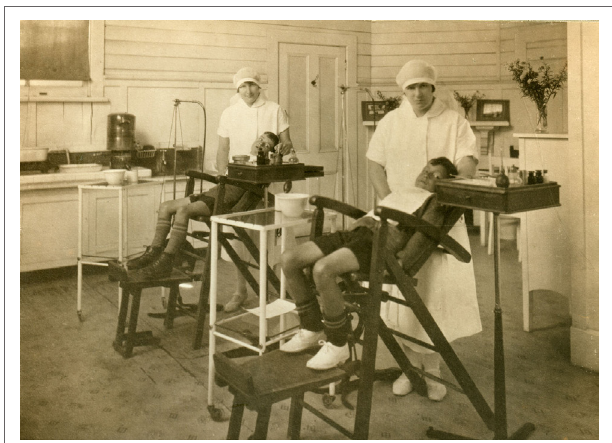
FiguRe 4 | “Double clinic”—the interior of the Napier dental clinic before the earthquake [Archives New Zealand/Te Rua Mahara o te Kawanatanga, Wellington Office (Archives Reference 672/1)]. The dental clinic was destroyed during the 1931 Napier earthquake. Fortunately, the dental nurses and their patients escaped with very little injury